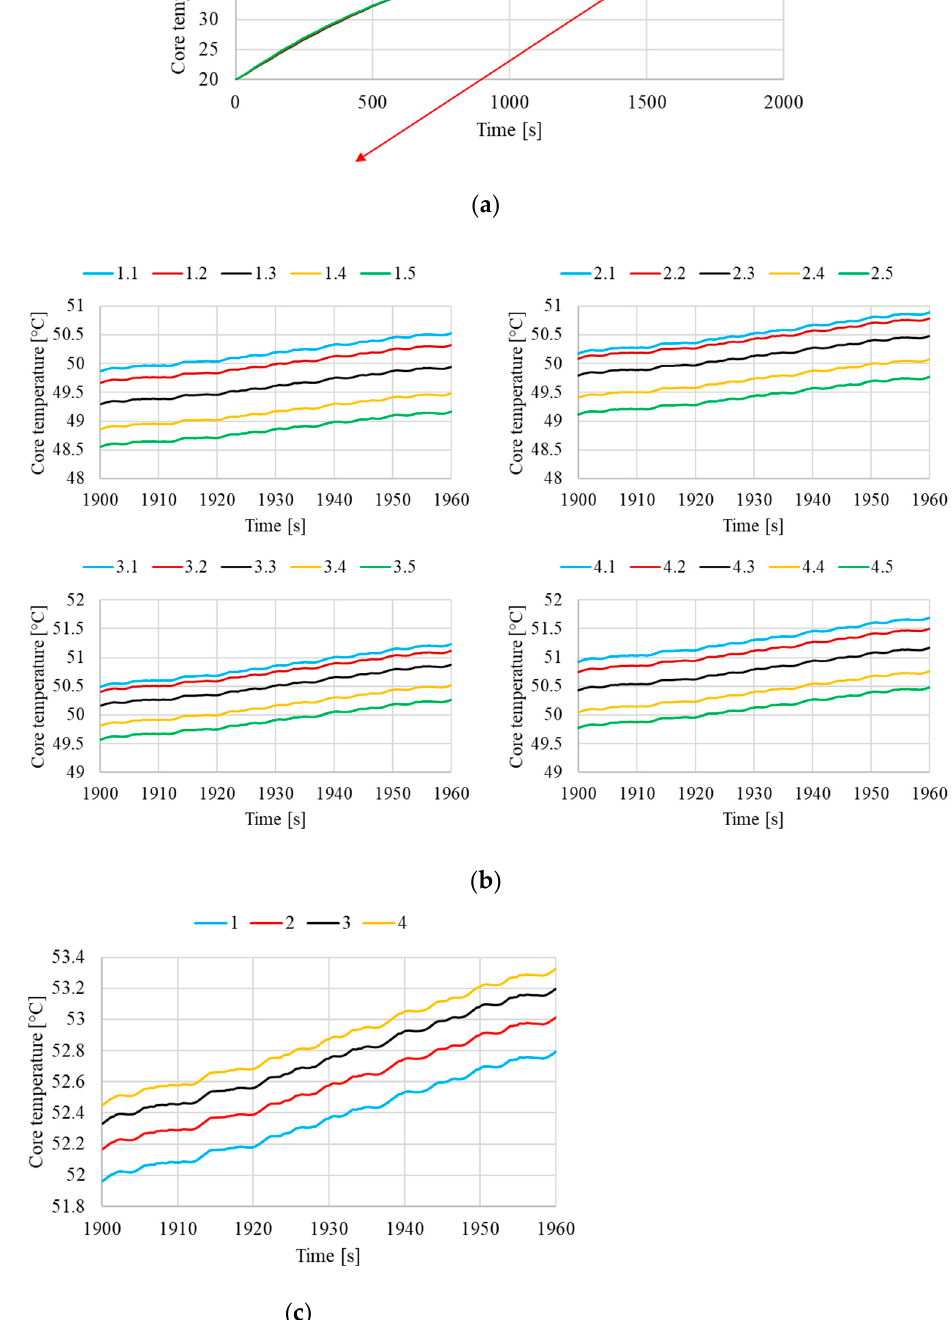
Figure 12. Battery core temperatures ( a ) in the 1st module; ( b ) in all 4 modules in the last minute; ( c ) in all 4 modules in the last minute, using the non-sectioned model.